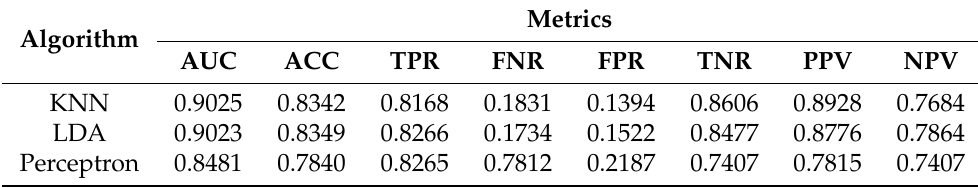
Table 2. The mean value for each metric for each algorithm—Cleveland Heart Disease dataset.